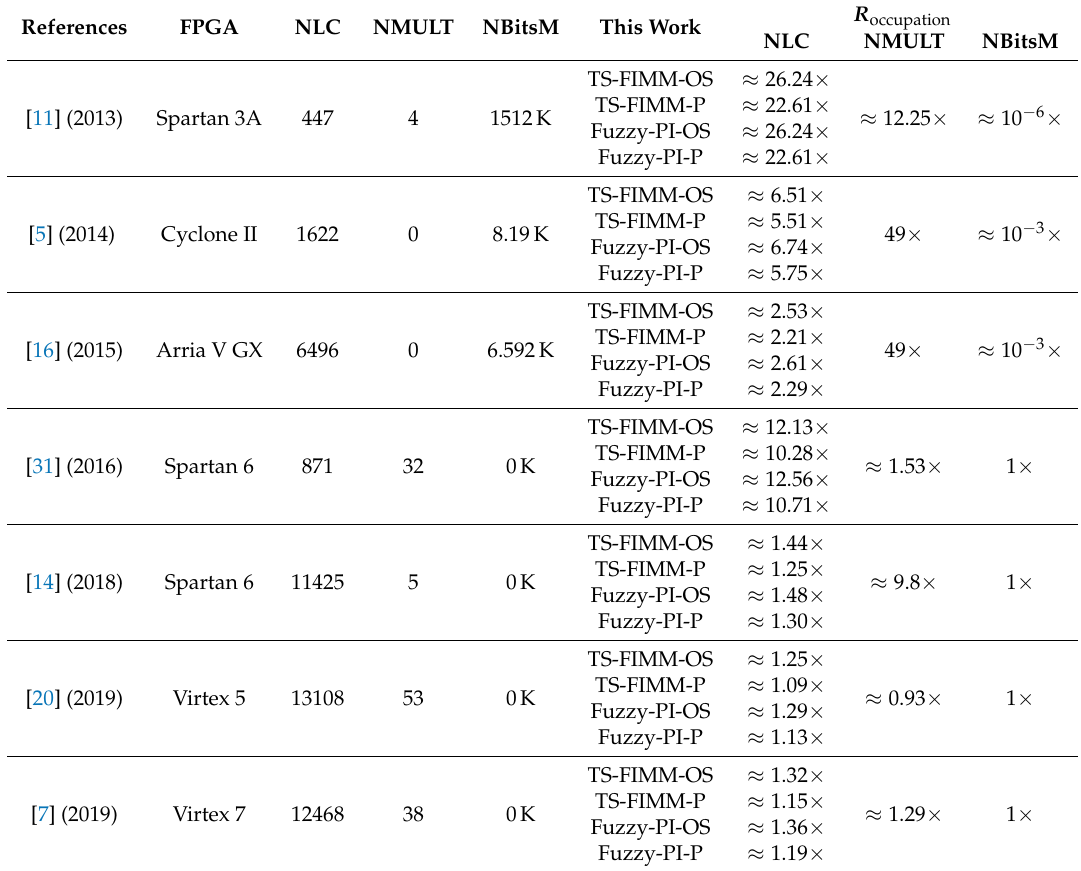
Table 8. Hardware occupation comparison with other